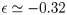
An example of long–range negative epistasis with ϵ≃−0.32.Panel (A) describes the reference fold obtained for the initial sequence, while panels (B) and (C) describe the reference folds obtained for the single mutants; Individual mutations T15 (yellow) → R15 (orange) and W4 (blue) → C4 (blue) in panels (B) and (C) are slightly deleterious and neutral, with ΔP1≃−0.17 and ΔP2≃0.02 respectively (ΔP12≃−0.47). W4 is ordered (T15 is disordered) in the initial ensemble, while R15 and C4 are ordered in the single mutant ensembles. The mutation T15 → R15 brings the mutant amino acid R15 in contact with W4. However, this structure (B) conflicts with the mutation W4 → C4 (the interaction between R and C is repulsive). The distance between mutated positions in panel (A) is R≃6 Angstroms. Folded ensembles for the initial and mutated sequences are shown in S7 Fig.